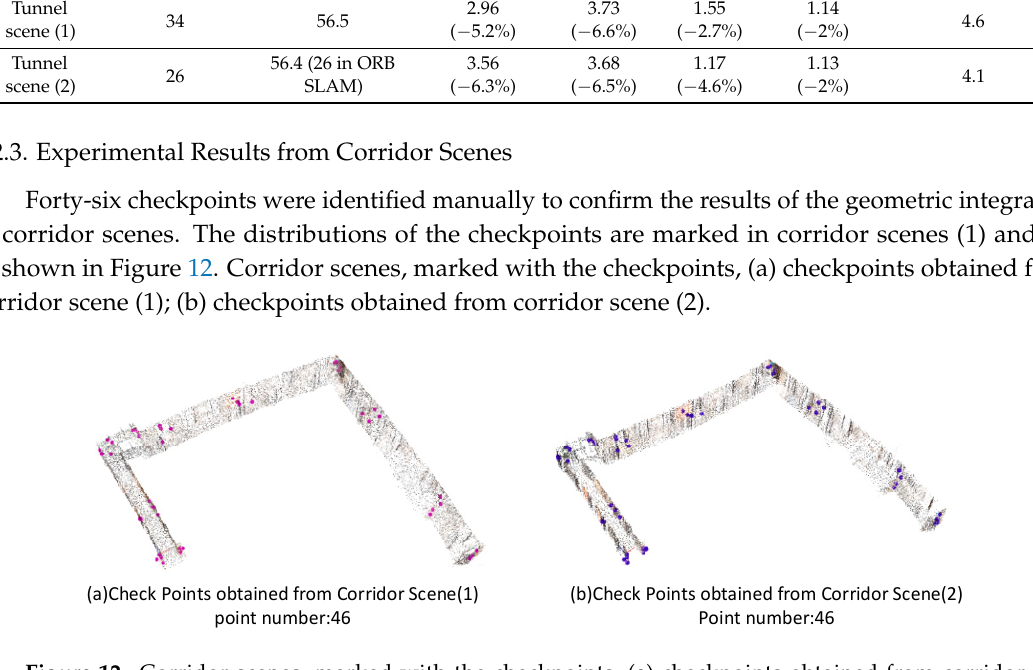
Figure 11. Absolute mapping errors of the checkpoints along with camera trajectories. Table 3. Absolute mapping accuracy of tunnel scenes using different SLAM methods.